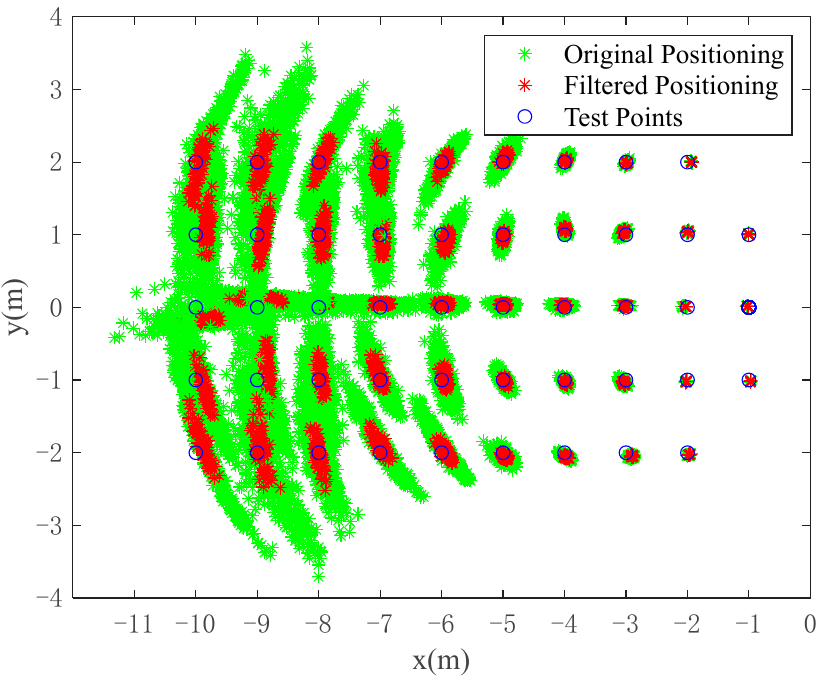
Figure 14. Underwater static positioning results (the green points are the original positioning data; the red points are the filtered positioning data; the blue points are the test points).